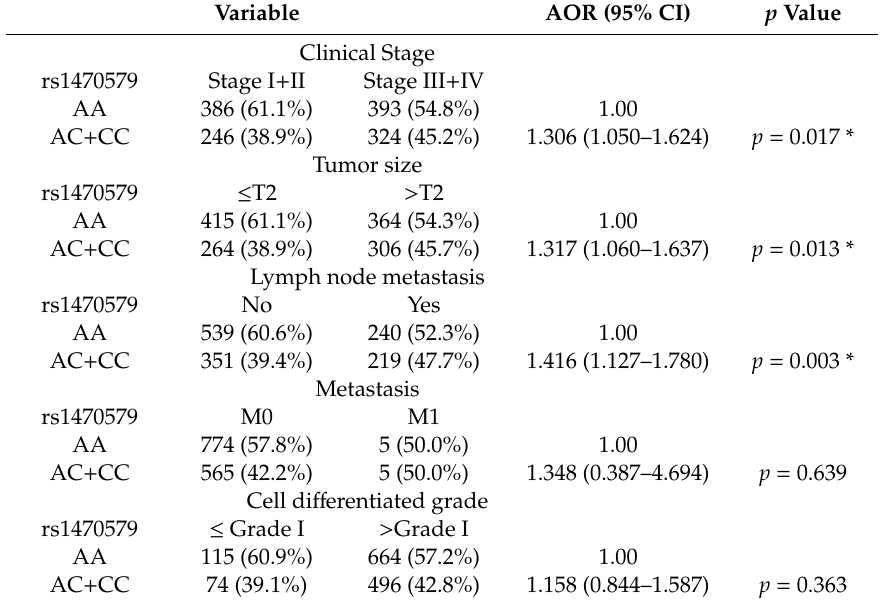
Table 5. Odds ratios and 95% CIs of clinical status associated with genotypic frequencies of IGF2BP2 rs1470579 in male patients with oral cancer ( n =